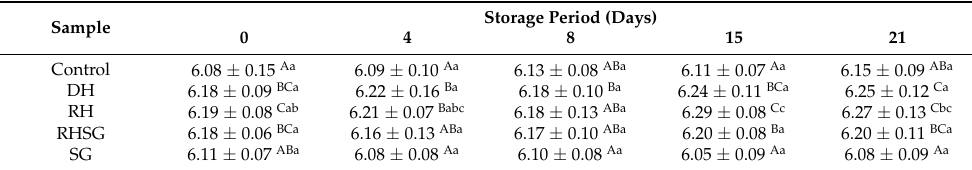
Table 3. Effects of additives and storage period (days) on the pH-value of grilled patties. Values are least square means ± standard